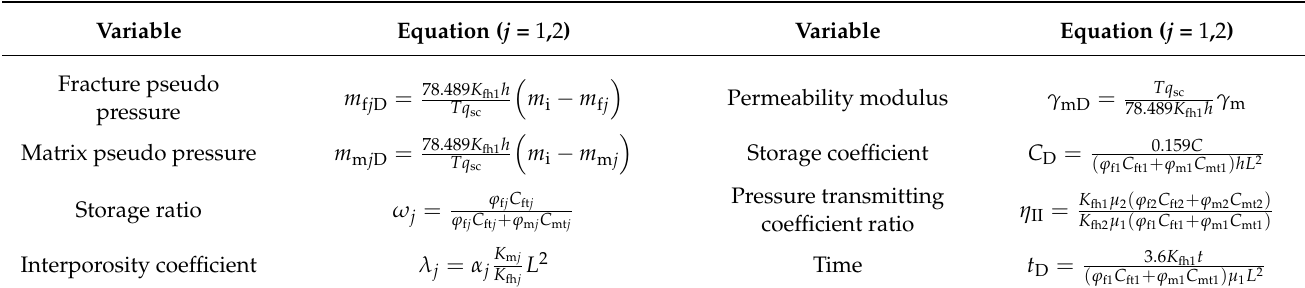
Table 1. Dimensionless variables of the dual medium